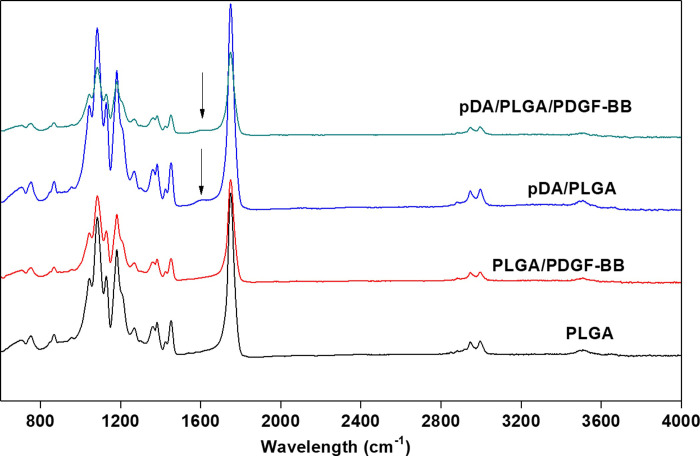
FI-TR spectrum.FI-TR spectrum of pDA/PLGA/PDGF-BB, p-DA/PLGA, PLGA/PDGF-BB, and PLGA fibers.